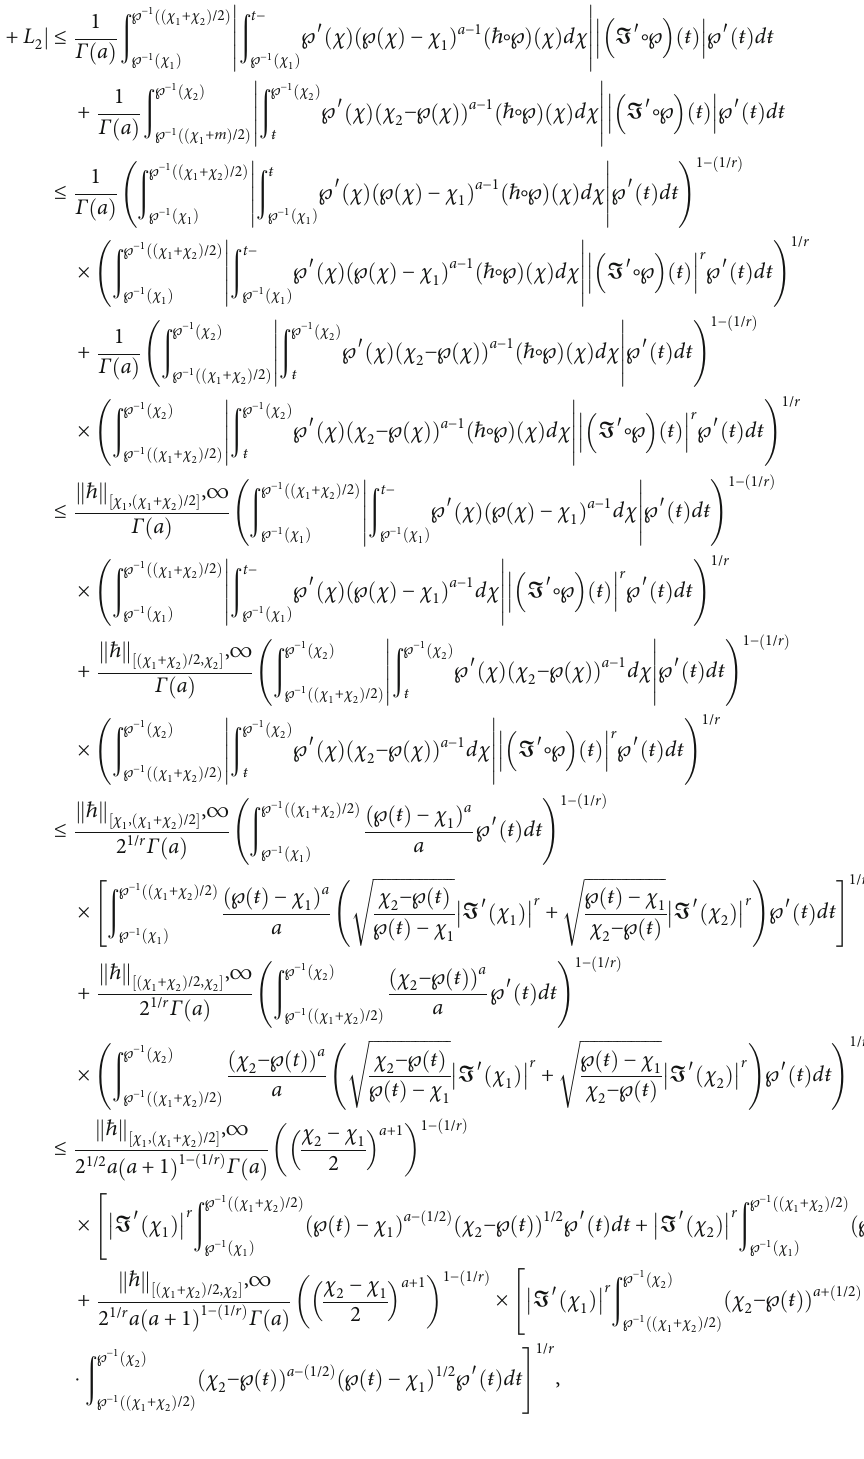
ffiffiffiffiffiffiffiffiffiffiffiffiffiffiffiffiffiffi χ − ℘ ŧ ð 2